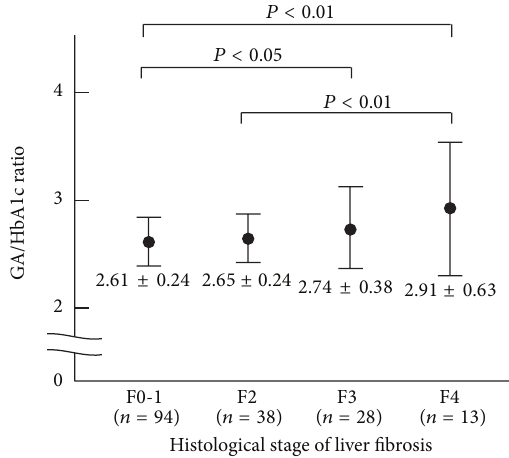
Figure 1: GA/HbA1c ratios in relation to the METAVIR fibrosis scores among the HBV-positive patients. The GA/HbA1c ratio increased in association with the stage of liver fibrosis. There were significant differences between the F0-F1 versus F3, F0-F1 versus F4, and F2 versus F4 groups.